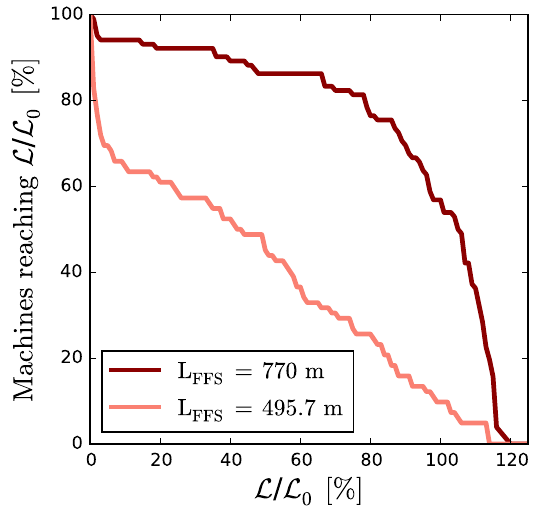
FIG. 23. Tuning efficiency comparison after one iteration of BBA and three iterations of linear knobs for L L ¼ 770 m with L (cid:1) ¼ 6 FFS